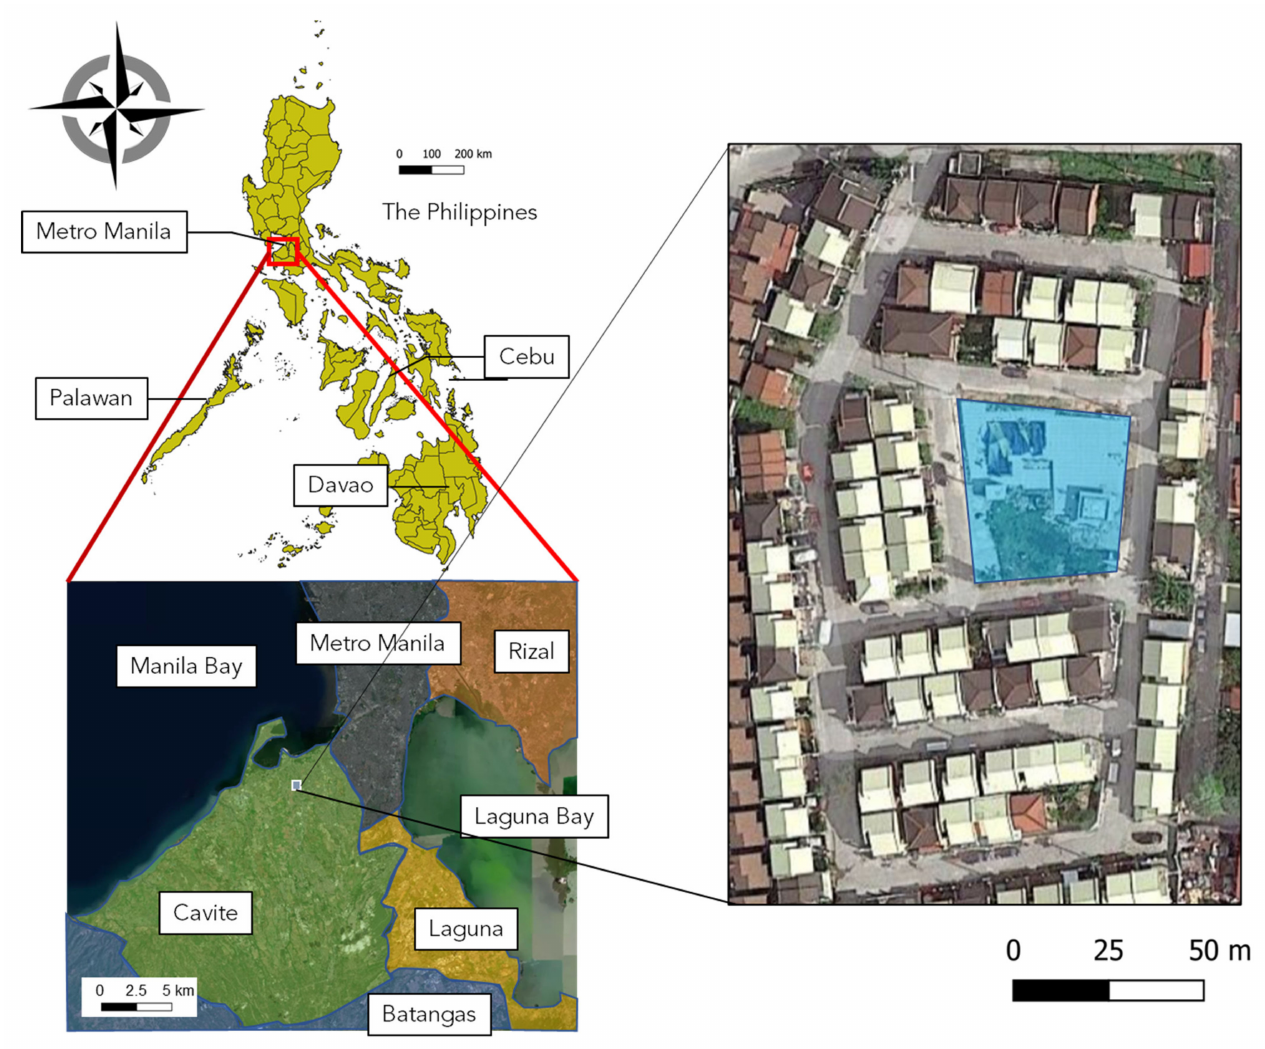
Figure 2. The geographical location of the study area in Bacoor, Cavite,